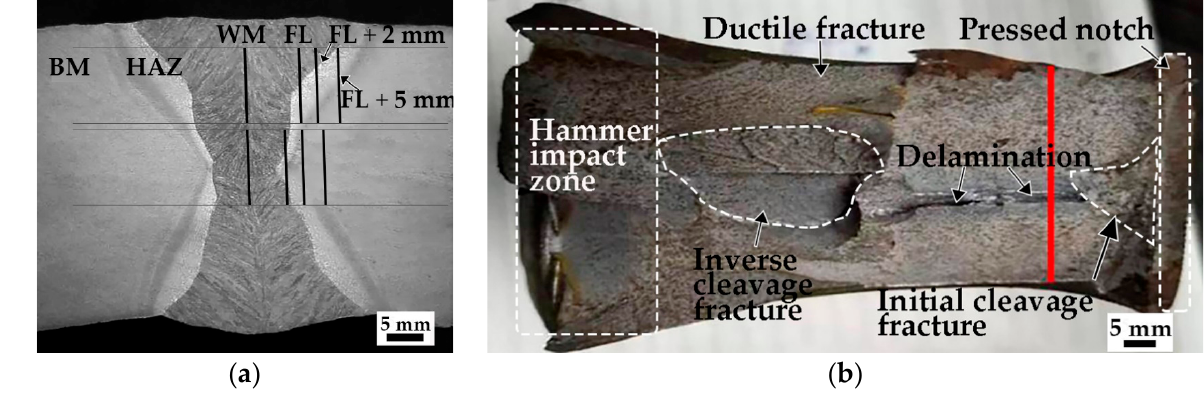
Figure 2. Macromorphology of the welded joint ( a ); and DWTT fracture surface ( b ). Electron backscattered diffractometry (EBSD) analysis was used for the crystal analysis of the delamination cracks in a field emission scanning electron microscope (FESEM; ZEISS, Oberkochen, Germany). In this study, EBSD data were acquired at 20 kV with a 0.2 µ m step size. The raw data were analyzed using HKL Channel 5 software (2007 version; Buehler, Oxford, UK) to acquire the crystallographic